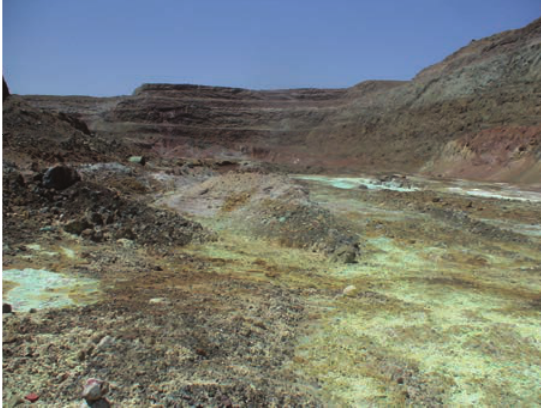
Figure 3. Photograph shows the jaw crusher.